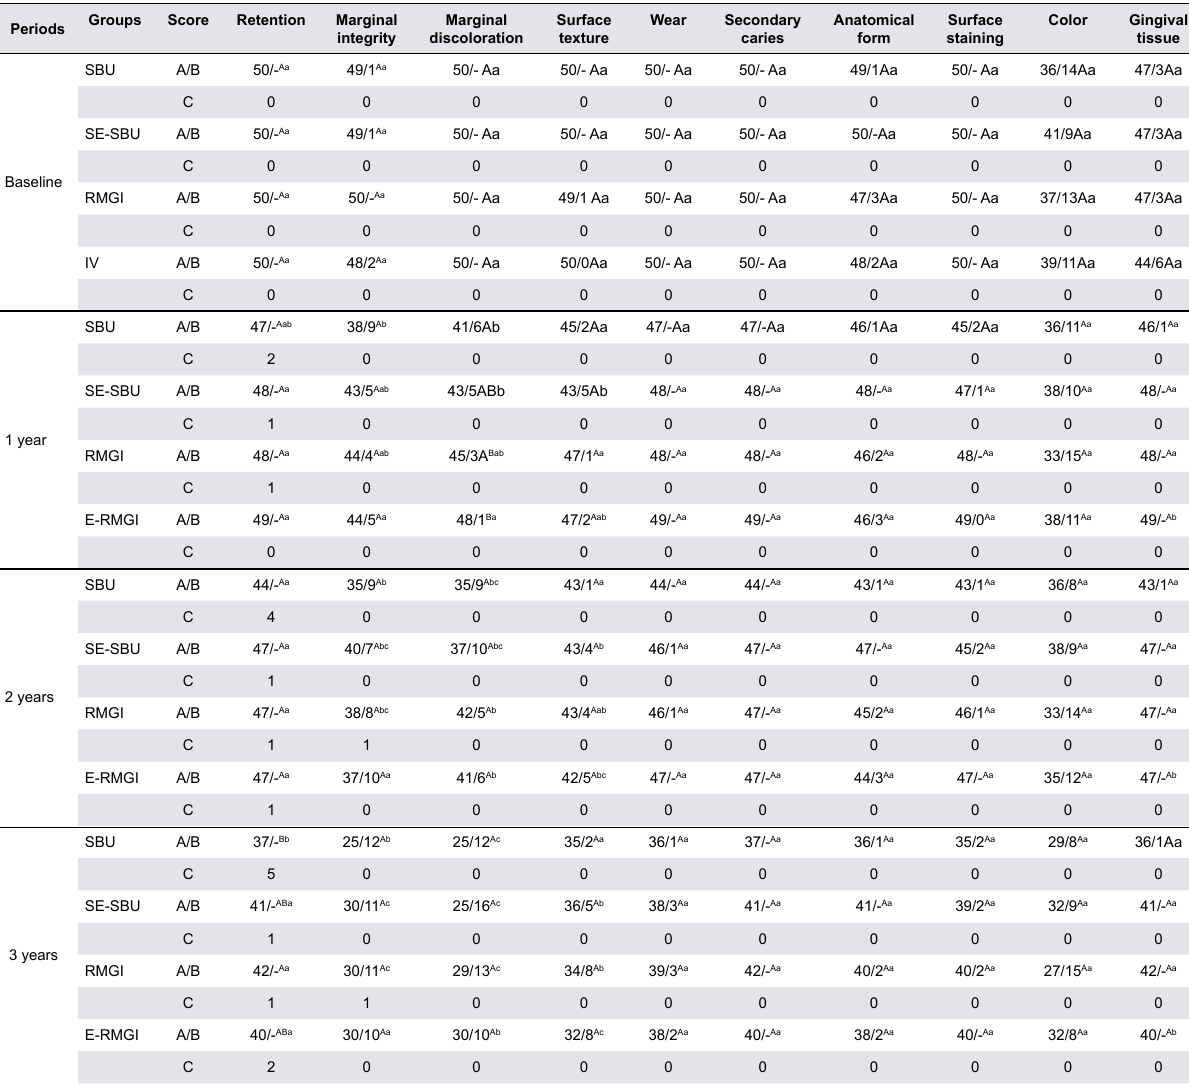
Table 1- Numerical restoration results per group according to each criterion at baseline, and 1, 2 and 3 years after the